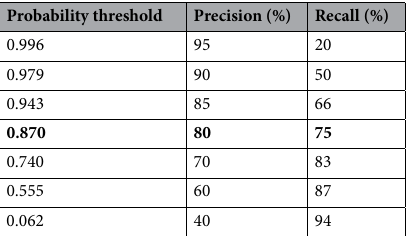
Table 1. The precision and recall of the MAPSHB model with different probability thresholds. The recommended threshold and its relevant metrics are highlighted in bold.